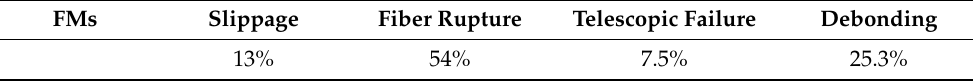
Figure 15. The effectiveness of eccentricity load and corrosion on load-deflection curves in terms of repaired and unrepaired columns. Table 13. The percentage of FMs in strengthened column in terms of the number of Table 12. An overview of studies on concrete columns strengthened with FRCM.